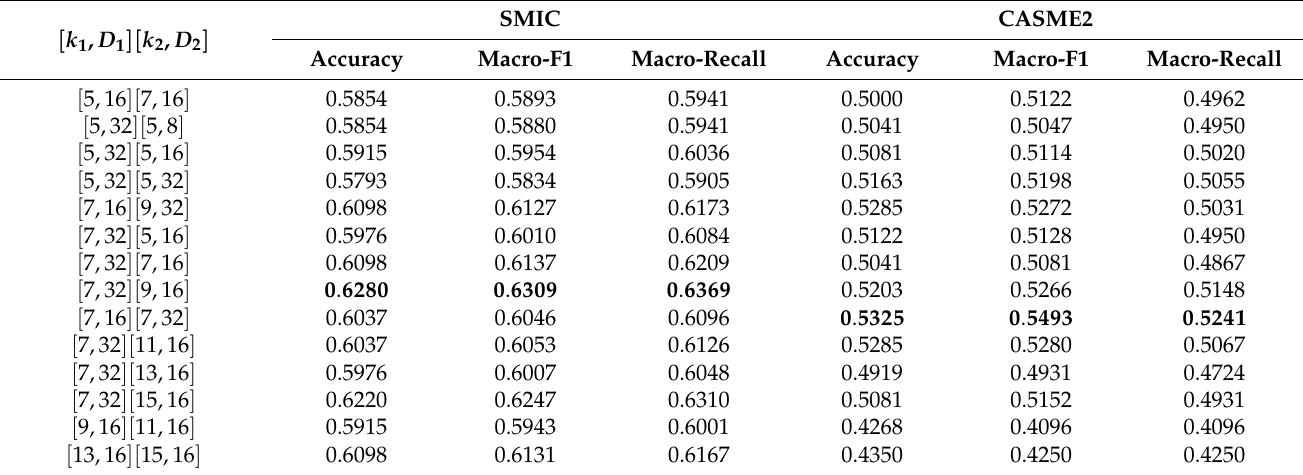
Figure 5. The visualization of feature maps produced in each layer for an input video clip from CASME2 dataset. Table 4. ME recognition results of OF-PCANet+ with respect to different number and size of filters [ k , D ]